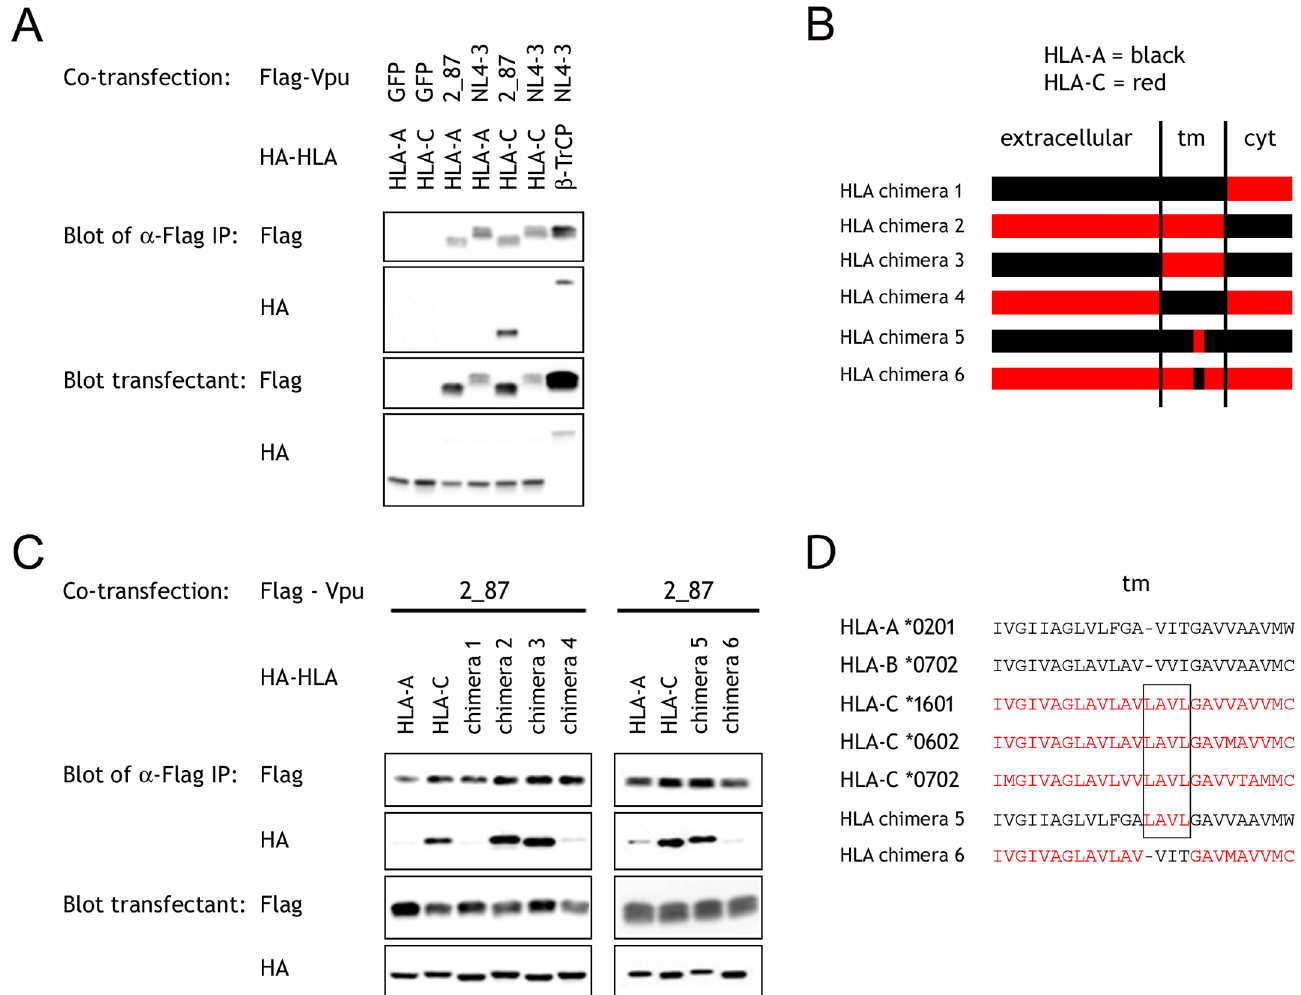
Fig 5. Transmembrane domain residues of HLA mediate the interaction with Vpu. (A) 293T cells were transfected with Flag-tagged constructs of Vpu from a primary virus 2_87, Vpu from NL4-3, or GFP as a negative control. Cells were co-transfected with HA-tagged constructs of HLA from the A or C loci, or HA- tagged β -TrCP as a positive control. Flag immunoprecipitation was followed by western blotting with anti-Flag or anti-HA antibody, and blots of the lysate prior to immunoprecipitation are also shown. (B) Chimeras 1–6 were constructed with the regions exchanged between HLA-A and HLA-C shown. (C) Co- immunoprecipitations were repeated using Vpu from 2_87 and the chimeric HLA constructs. (D) Sequences of the transmembrane domain of representative HLA-A and HLA-B alleles, 3 alleles which represent the transmembrane sequences of all common HLA-C alleles, and the chimeric constructs 5 and 6. Complete sequences for all HLA constructs are detailed in S8